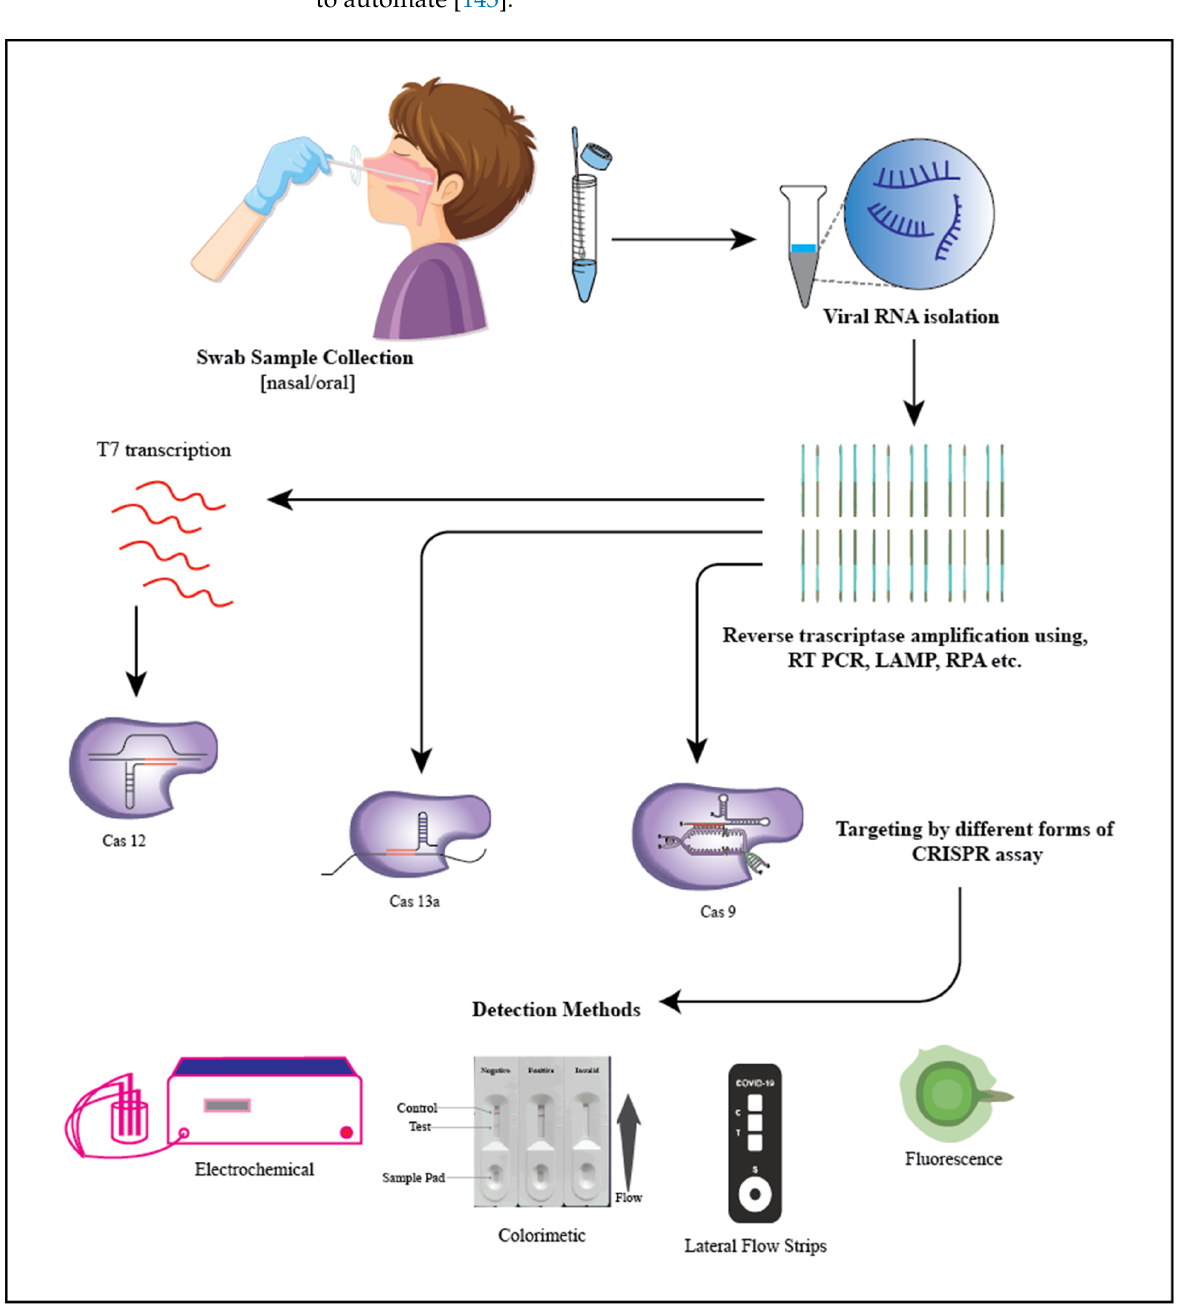
Figure 3. Five-step workflow of CRISPR-based detection system to detect SARS-CoV-2 virus. (1) Sample collection using nasal or oral swabs. (2) RNA molecules are extracted and isolated from the sample, as SARS-CoV-2 is an RNA-based virus. (3) Isolation is followed by an amplification procedure such as RT-PCT, RT-RPA, or RT-LAMP to increase the LOD, (4) followed by detection using the CRISPR-Cas system and (5) detection using fluorescence, colorimetry, electrochemical, or other sensory readout methods.